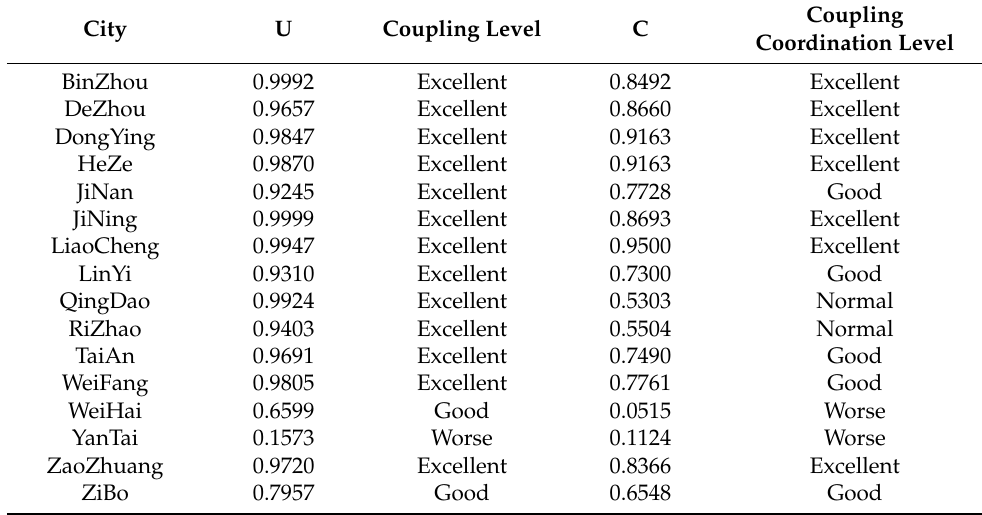
Table 3. Statistics of coupling degree and coupling coordination degree between AOD and